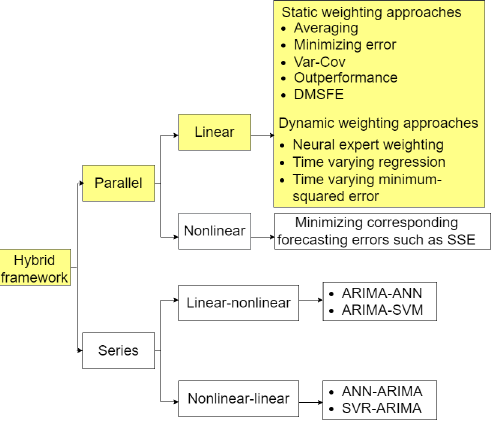
Figure 1. The schematic framework of the hybrid process